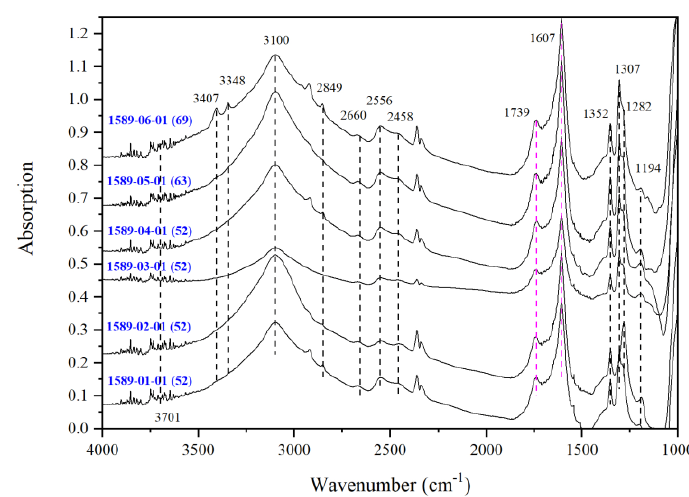
Figure 7. Unpolarized IR spectra taken on different crystal plates made from the intemediate-H 2 O Mg-Rw in Run 1589. The IR # is followed by the measured thickness of the crystal plate ( D m in parentheses). Note the absence of any interference fringes in these spectra, suggesting that all thin sections are wedged.